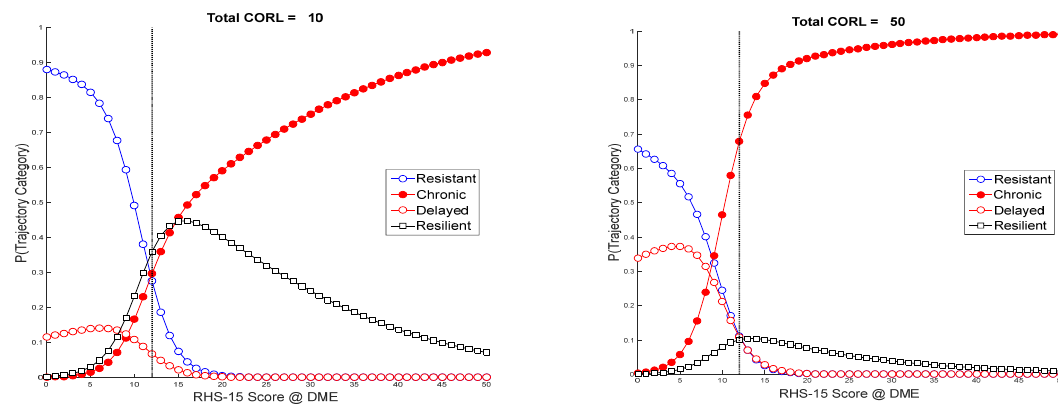
Figure 2. Effect of loss score on trajectory probability.